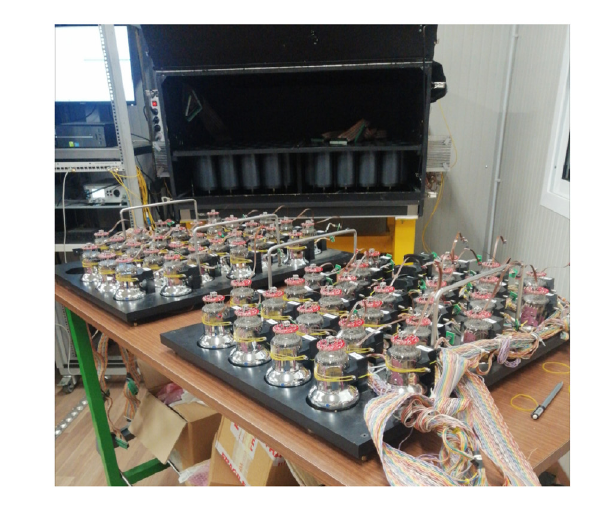
Figure 1: The dark box apparatus and two trays of R14374 PMTs ready for test